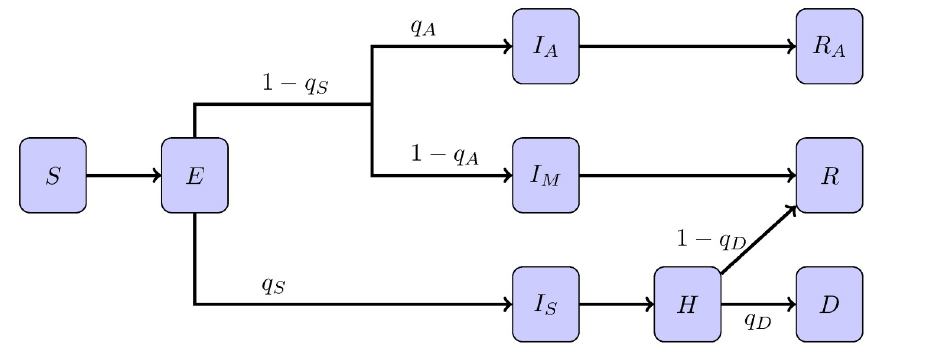
Fig 7. Diagram for epiABM with categories to account for unreported